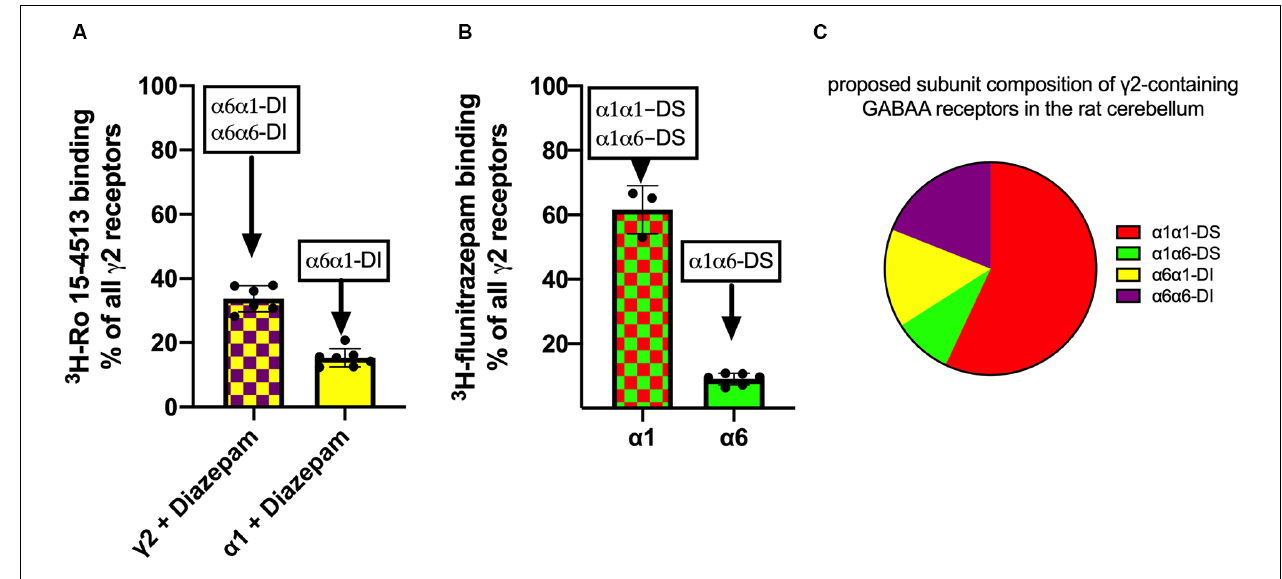
FIGURE 5 | Analysis of γ 2-containing receptors in rat cerebellum. GABAA receptors were extracted from rat cerebellum, precipitated with subunit specific antibodies, and quantified using 5 nM 3 H-Ro 15-4513 with or without diazepam panel (A) or 2 nM 3 H-flunitrazepam panel (B) . The data shown are mean ± SD of 4–7 independent experiments performed in duplicates each. Panel (C) : the diagram illustrates the proposed subunit composition of γ 2-containing GABAA receptors in the rat cerebellum. The pie chart is constructed from the data obtained from experiments depicted in panels (A,B) .